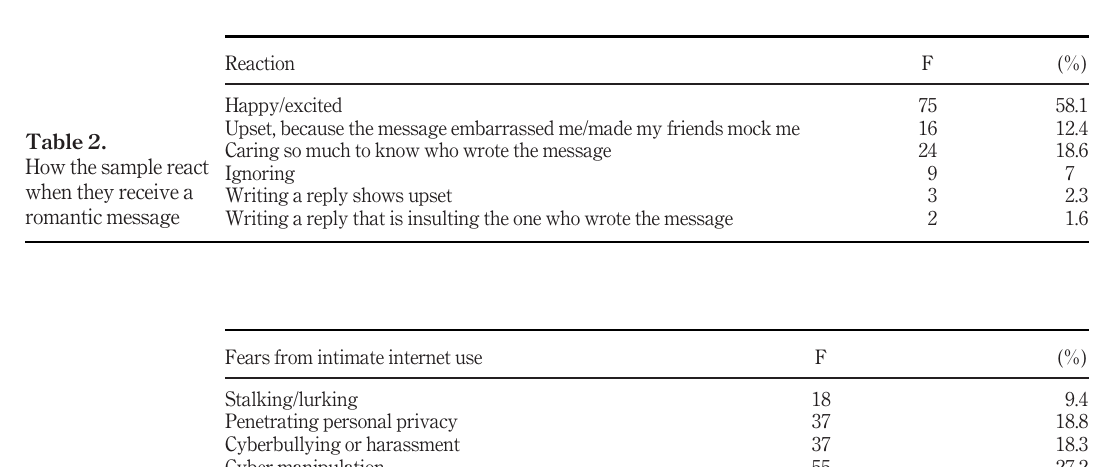
Table 3. Why fear online